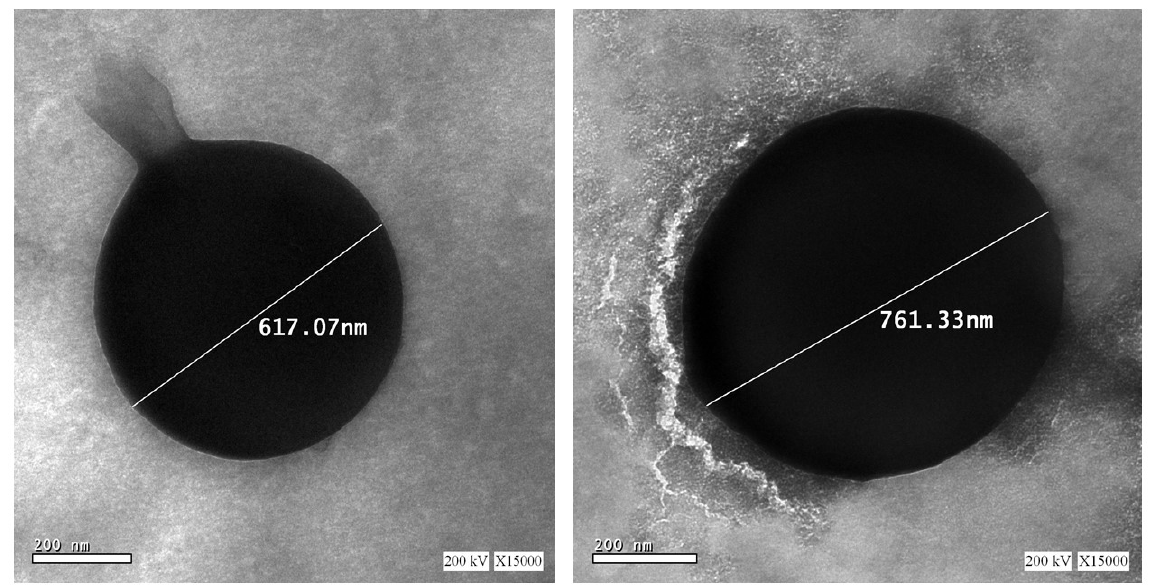
Figure 7. TEM images SCM8–1 formulation showing the spherical-shaped particles with their par- ticle size values (scale bar: 200 nm).